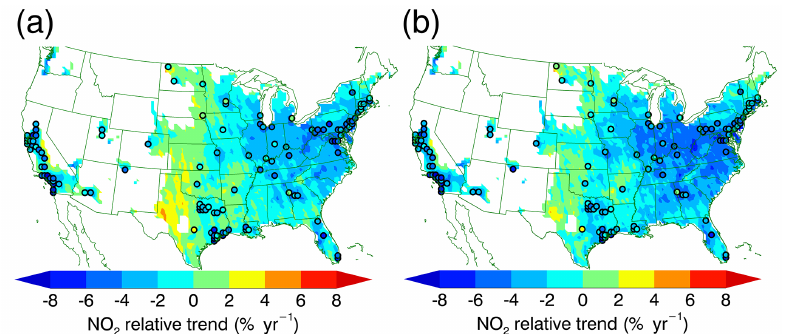
Figure 8. Annual relative trends of OMI-based NO 2 for “standard” (a) and for “lightning filter” (b) as the colored background. Black- bordered circles indicate corresponding AQS NO 2 trends. Grid cells with 2005–2014 mean NO 2 VCDs <1 × 10 15 moleculescm − 2 are excluded in the analysis and are shown in white.